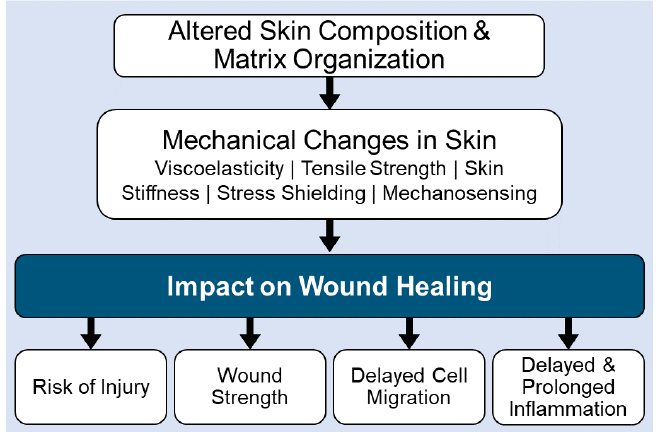
Figure 3. Impact of aging on skin composition, function & wound healing [6,34,38] .